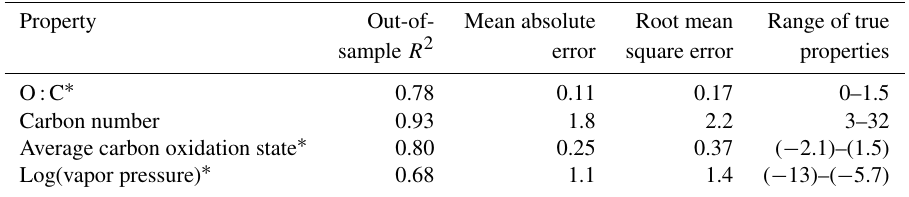
Table 3. Performance metrics for random-forest-based modeling of chemical properties of the ambient aerosol sample extrapolation set. Range of true properties units in units of the property O:C, in unitless atom number:atom number, carbon number in atom number, average carbon oxidation state in mean charge, and log(vapor pressure) in